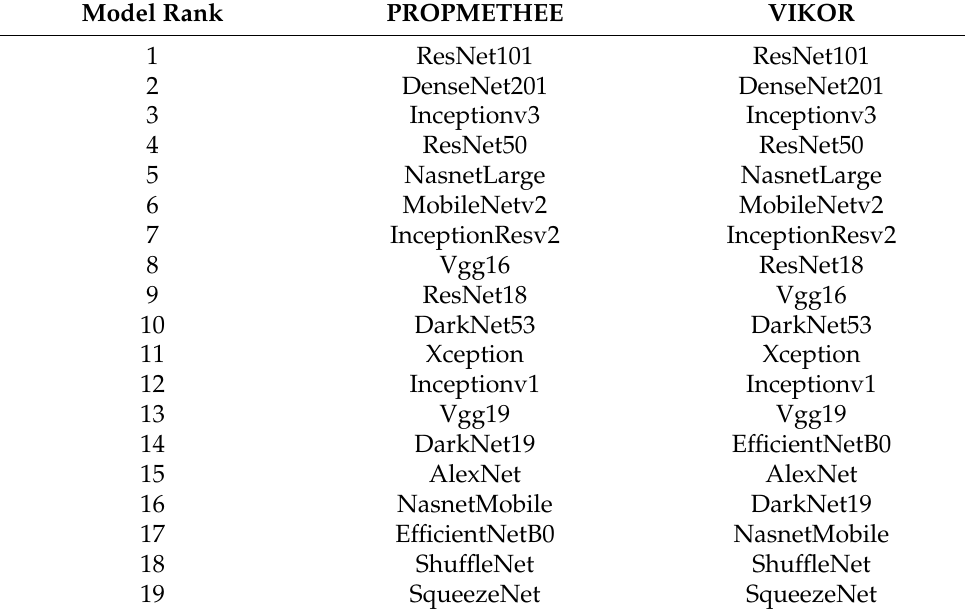
Table 6. Optimal CNN model selection in PROMETHEE versus VIKOR